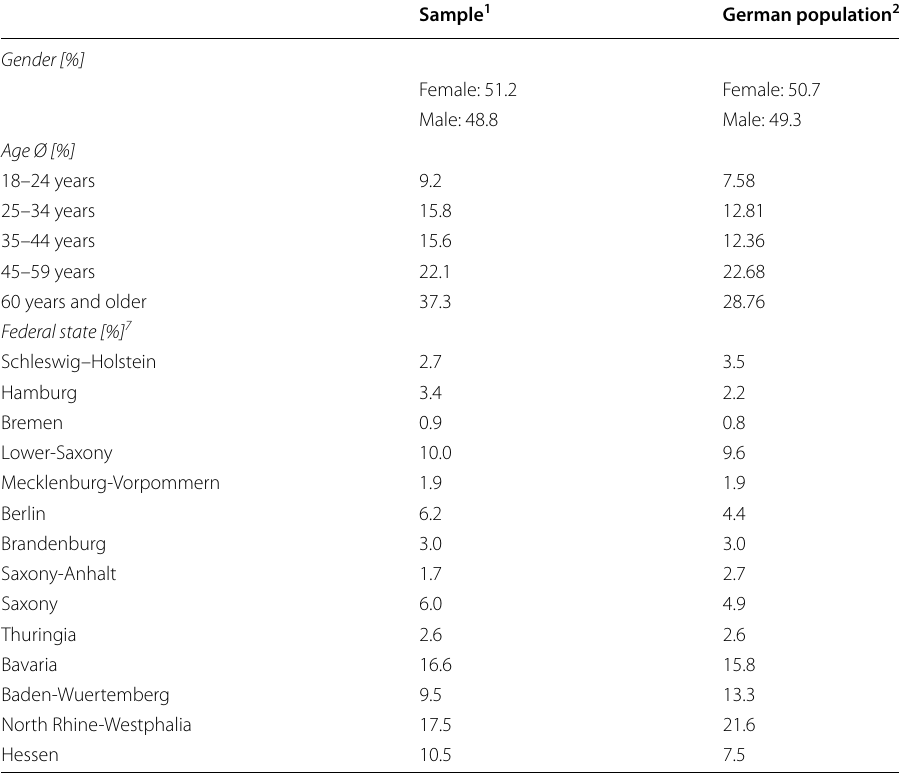
Table 2 Descriptive socio-demographic representation of the data sample. Source Authors’